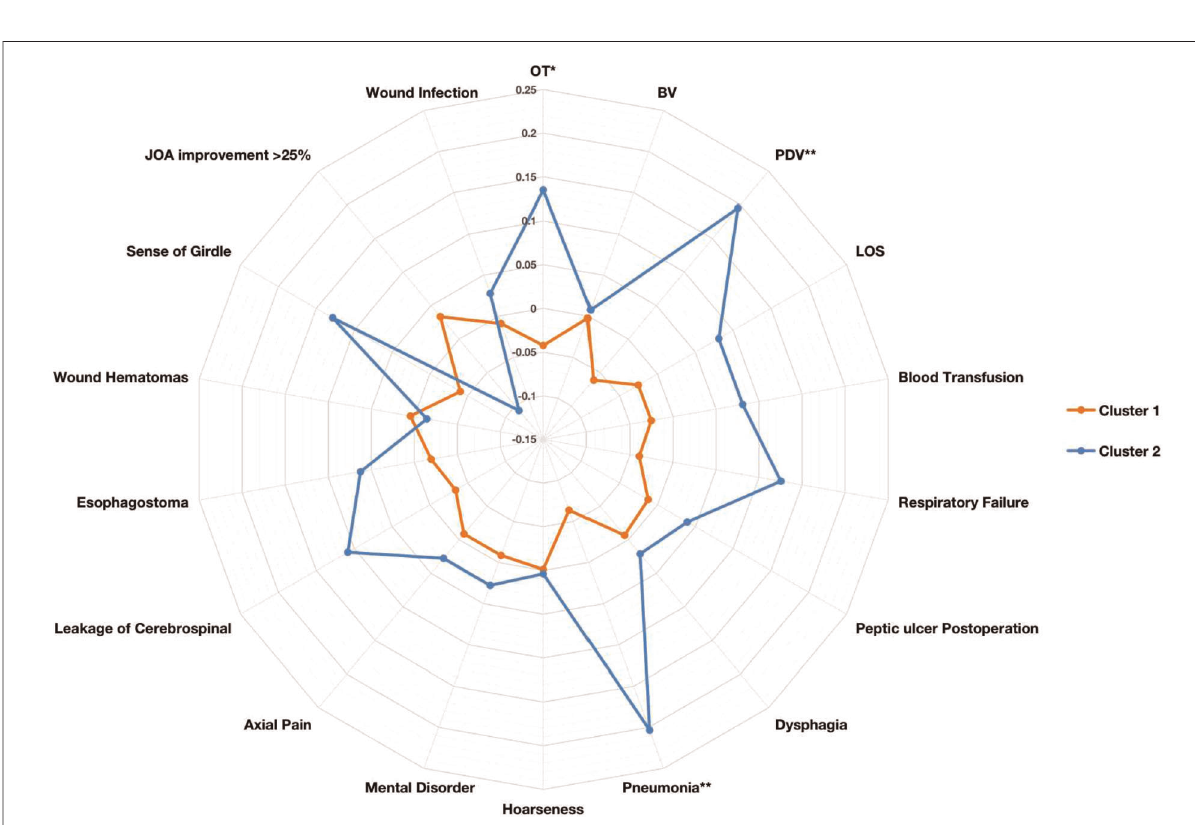
FIGURE 6 Radargram of 18 preoperative variables in cervical spondylotic myelopathy patients in two clusters. K-means clustering algorithm-normalized preoperative variables were compared between two clusters. Spoke lengths represent the average of each variable after the K-means clustering algorithm is normalized. Signi fi cance levels are presented with asterisks. OT: operation time; BV: bleeding volume; PDV: postoperative drainage volume; LOS: length of hospital stay. * p -value<0.05, ** p -value<0.01, *** p